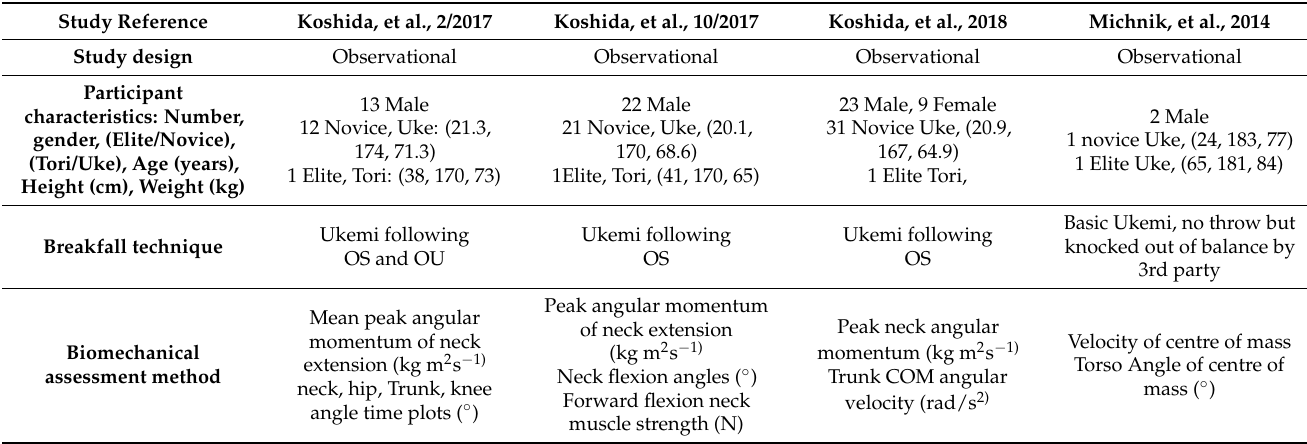
Table 4. Study characteristics and